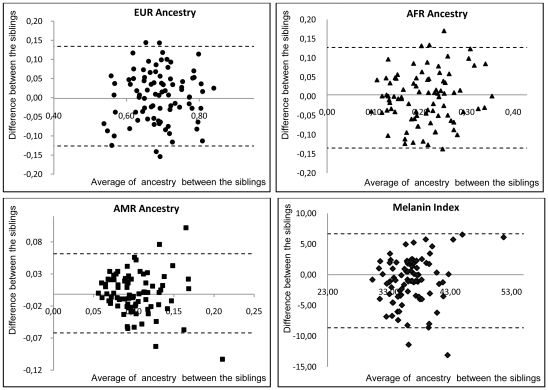
Bland-Altman Analysis.